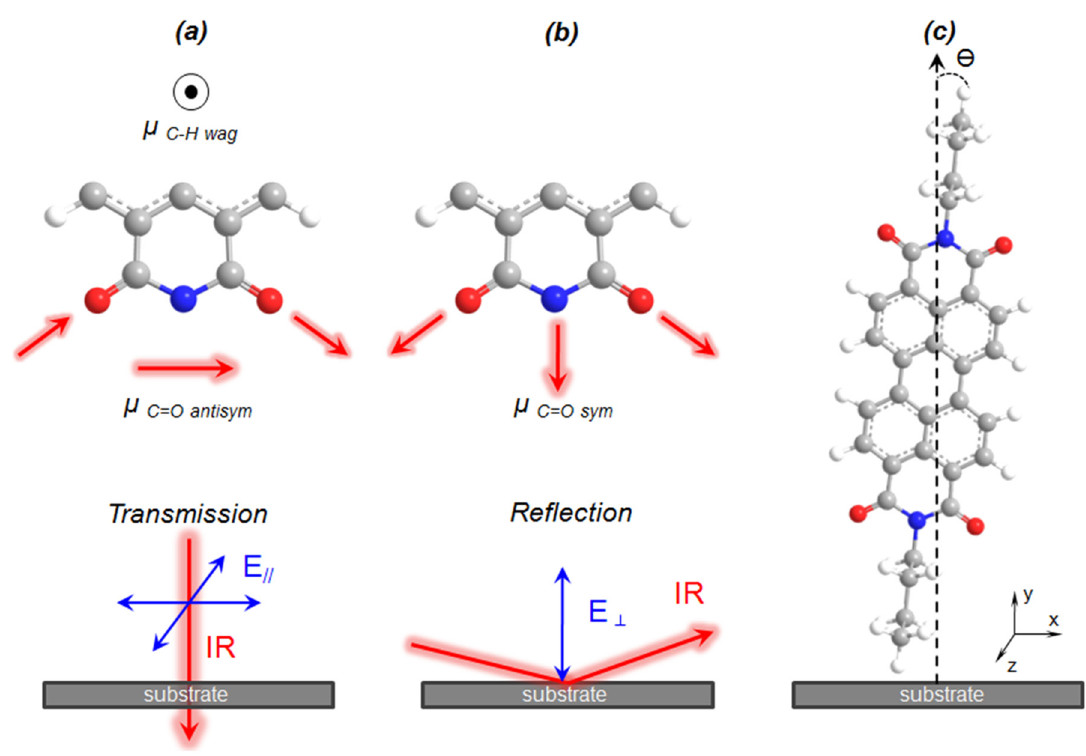
Figure 6. Resultant dipole moments (µ) and polarization of the incident electric field on (a) transmission and (b) reflection modes. (c) Scheme of molecular organization proposed for BuPTCD in PVD